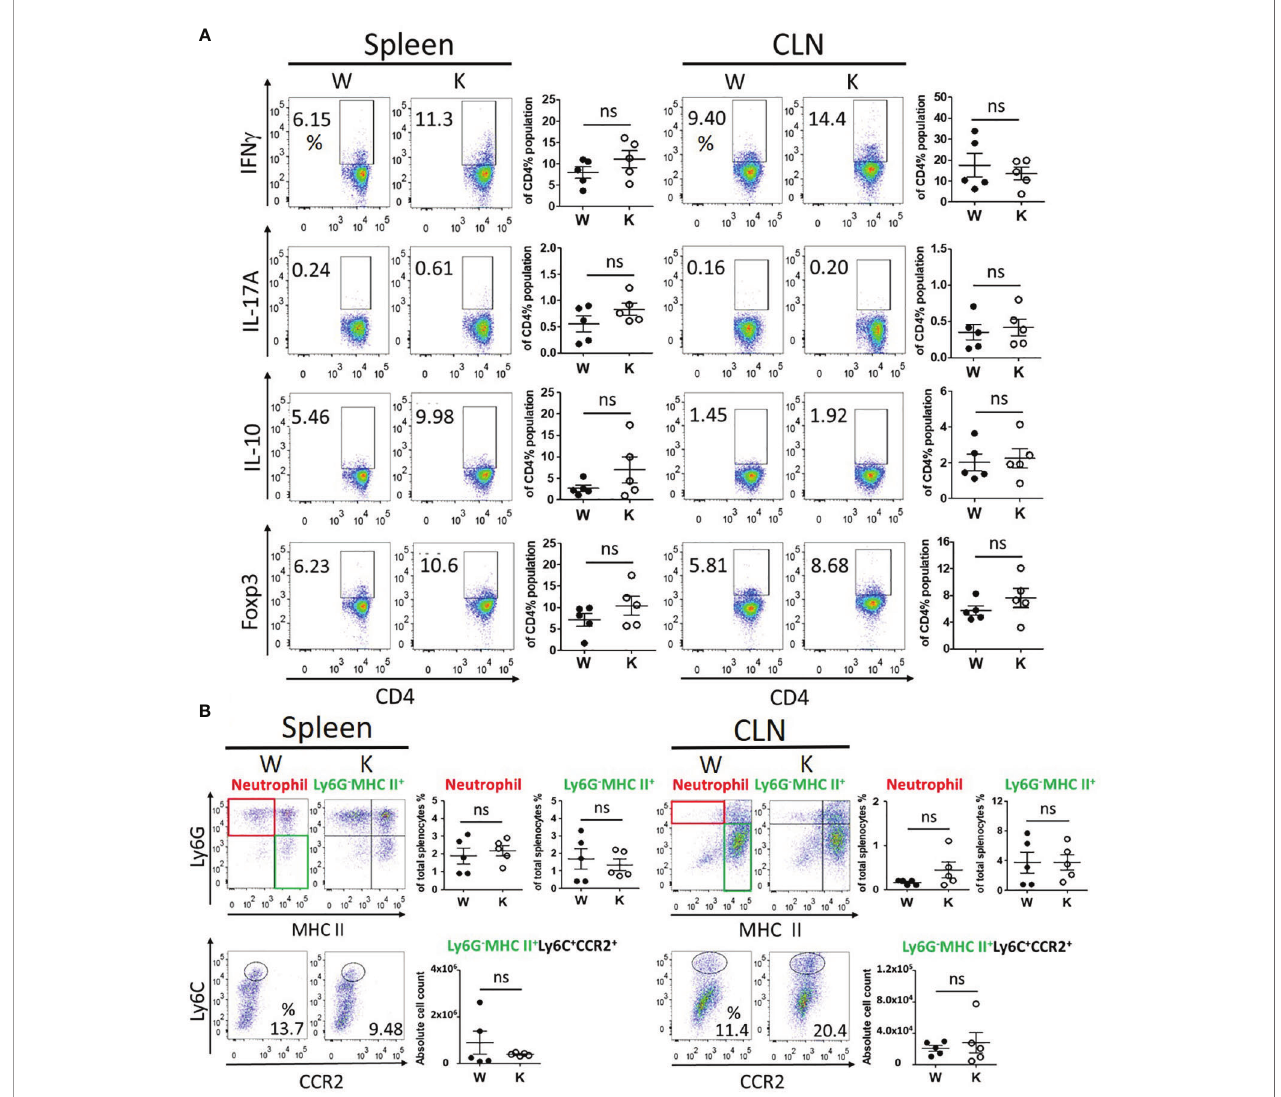
FIGURE 3 | Nox2-de fi cient group presented similar pro fi le of peripheral immune response as Nox2-competent group in spleen and cervical lymph nodes on disease peak (17 dpi). (A) the T cell pro fi les of IFN g (T H 1), IL-17A (T H 17), IL-10, and Foxp3 (Treg)-producing cells from splenocytes (spleen) and cervical lymph nodes (CLN) respectively between W and K groups (n = 5 each group). (B) the myeloid cell pro fi les (CD11b + CD45 hi ) of neutrophils (Ly6G + MHC II − ), monocytes (Ly6G - MHC II + ), and cell count of pathogenic monocytes (Ly6G - MHCII + Ly6C + CCR2 + ) from spleen and CLN respectively between W and K groups (n = 5 each group). p value: ns, not signi fi